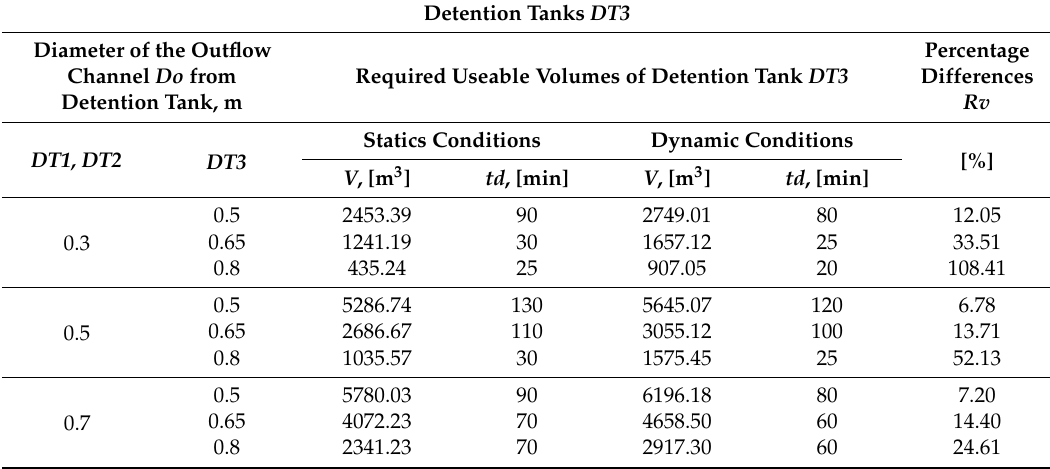
Table 6. Percentage differences of volume detention tank DT3 between static and dynamic